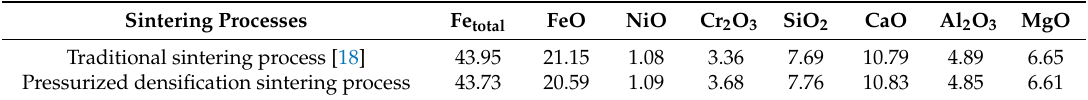
Table 3. Chemical compositions of product sinter of different sintering processes (wt%). Sintering